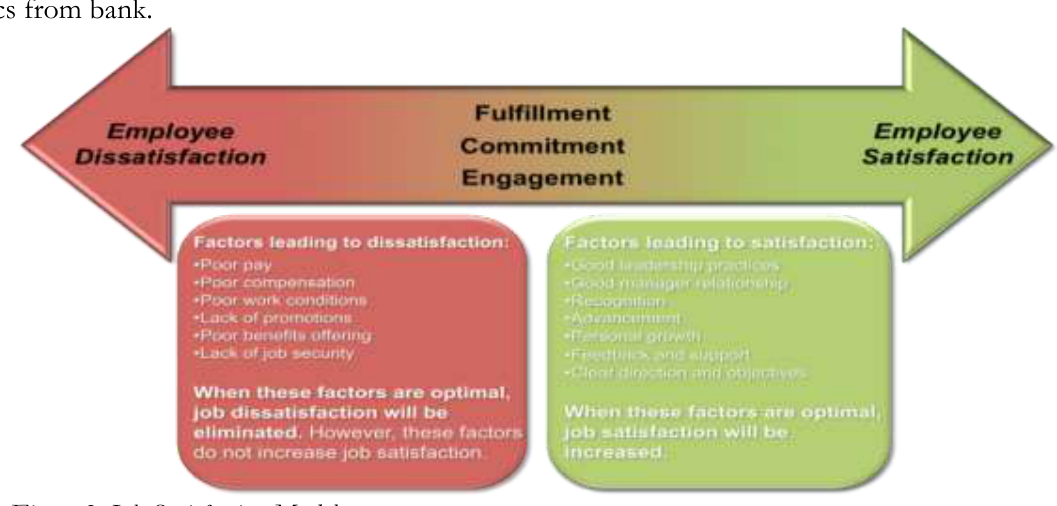
Figure 2: Job Satisfaction